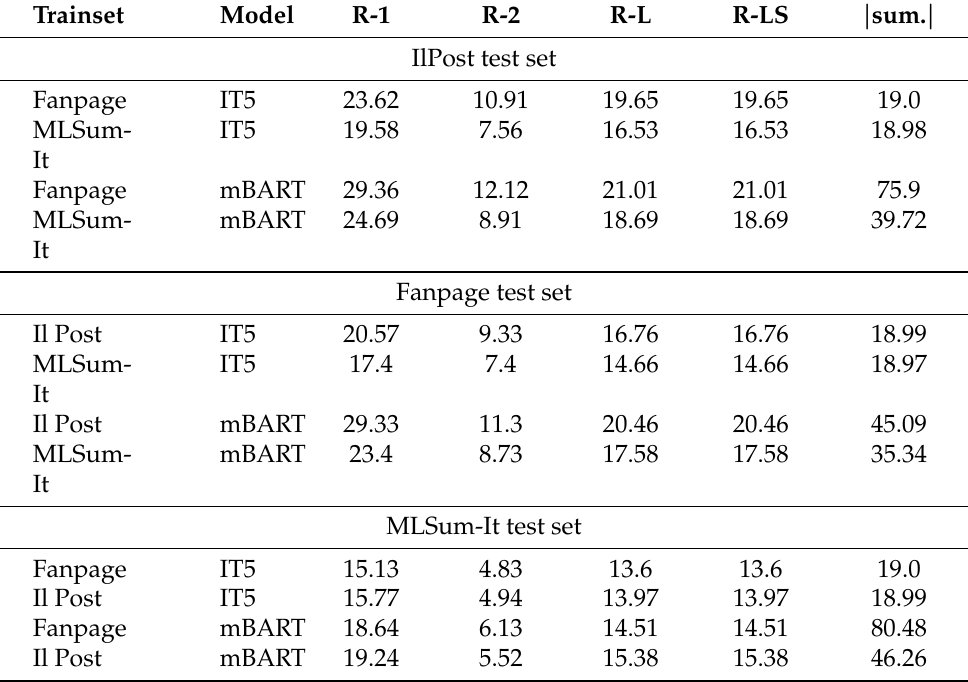
Table 6. Comparison of IT5 and mBART models when trained on a dataset and tested on another dataset. All combinations of the test and training sets of the MLSum-It, Fanpage, and IlPost datasets are reported in the table. The metrics reported are ROUGE-1 (R-1), ROUGE-2 (R-2), ROUGE-L (RL), ROUGE-LS (R-LS), and the average length of the summaries ( | sum. | ).